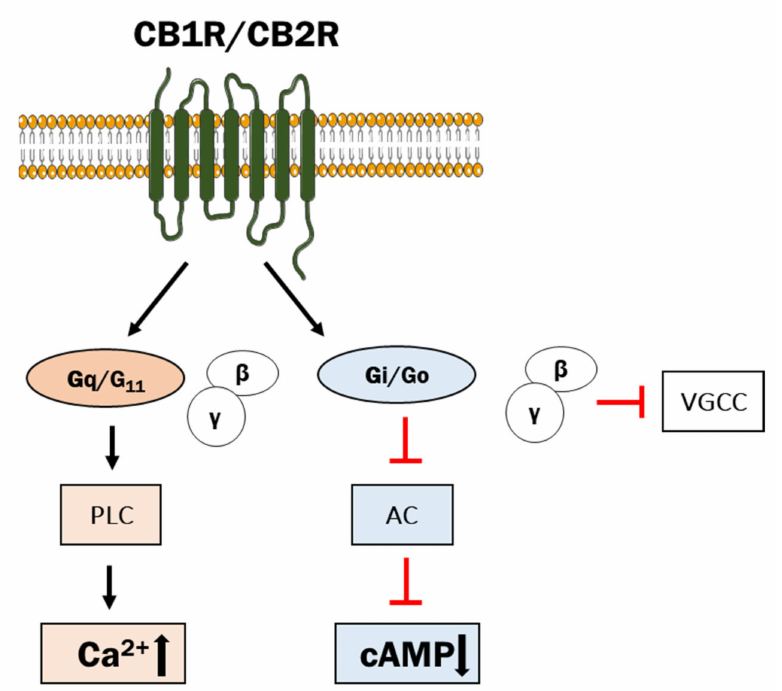
Figure 3. The scheme of receptor action of endocannabinoids. PLC—phospholipase C, AC—adenylyl cyclase. Inhibitory action is indicated by the red